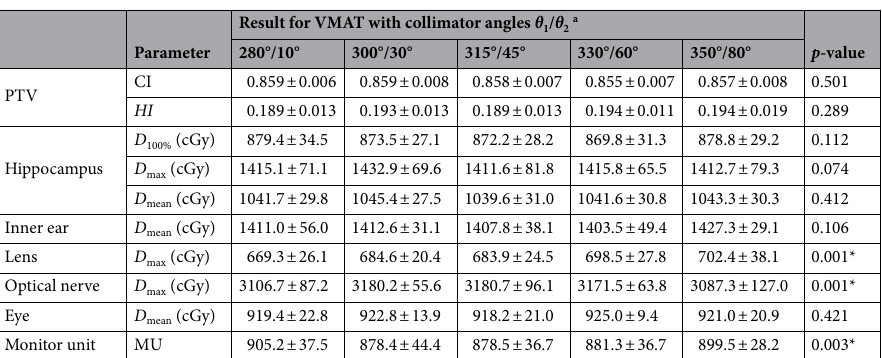
Result for VMAT with collimator angles θ 1 / θ 2 a